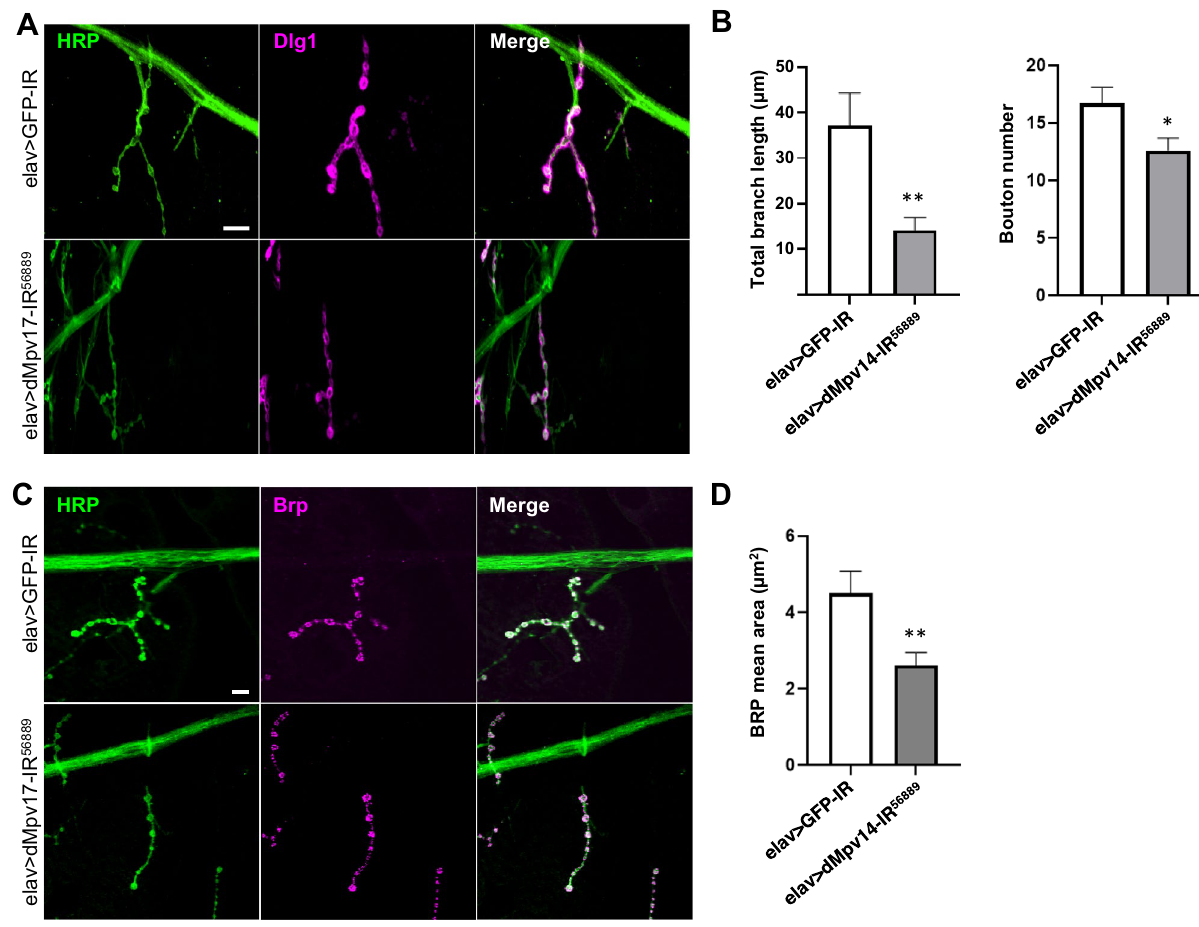
Figure 4. A dMpv17 knockdown influences larval NMJ morphology. ( A ) Synapses in the NMJ on the fourth muscle of third-instar larvae were inspected in elav > GFP-IR, elav > dMpv17-IR 42671 , and elav > dMpv17-IR 56889 larvae. The presynaptic terminals were visualized with anti-HRP IgG and the post-synaptic domains with anti- Dlg1 IgG. Scale bar, 10 μm. ( B ) Synapse branch length, bouton numbers were quantified. ** P < 0.01, * P < 0.05, statistical analysis was performed using Student’s t -test vs elav > GFP-IR. n = 15. ( C ) The active zone in the NMJ of the fourth muscle was visualized with anti-HRP and anti-Brp IgGs. Scale bar, 10 μm. ( D ) The area of Brp signals merged with HRP was quantified. ** P < 0.01, statistical analysis was performed using Student’s t -test vs elav > GFP-IR. n =